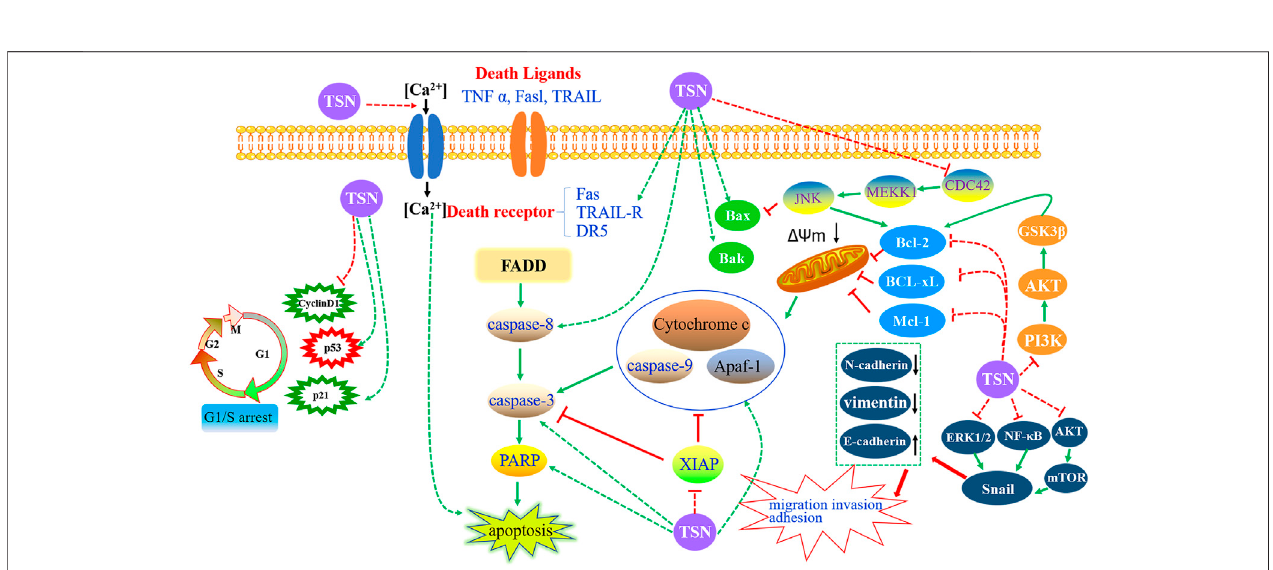
FIGURE 9 | Targeting the apoptosis signaling pathways by toosendanin in cancers.